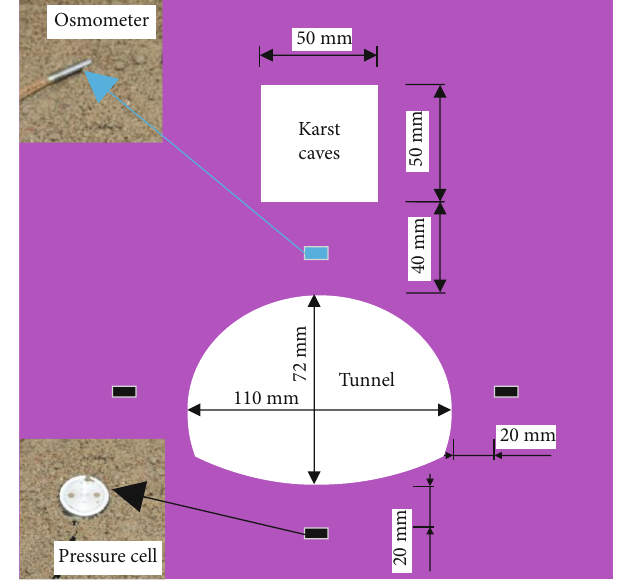
Figure 3: Model test